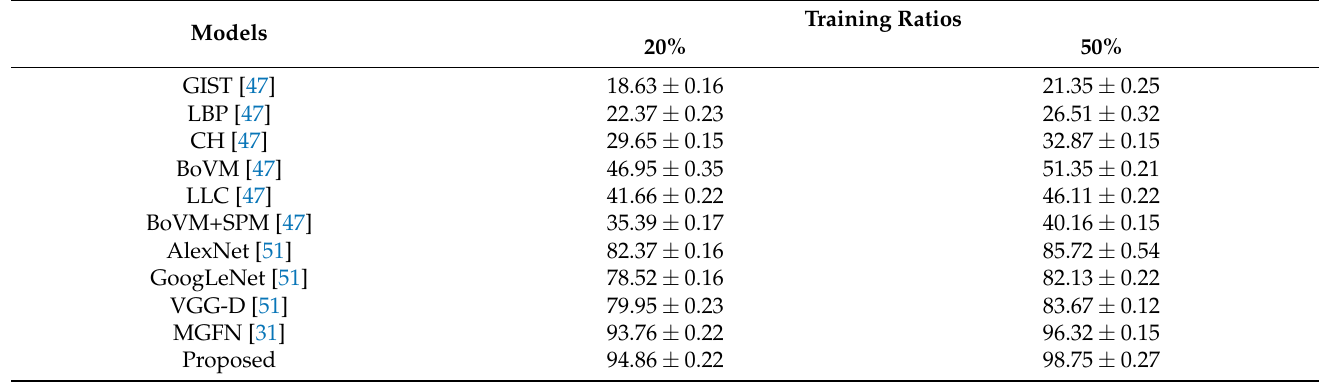
Table 2. Overall accuracies(%) of ten kinds of methods and our method under the training ratios of 20% and 50% in